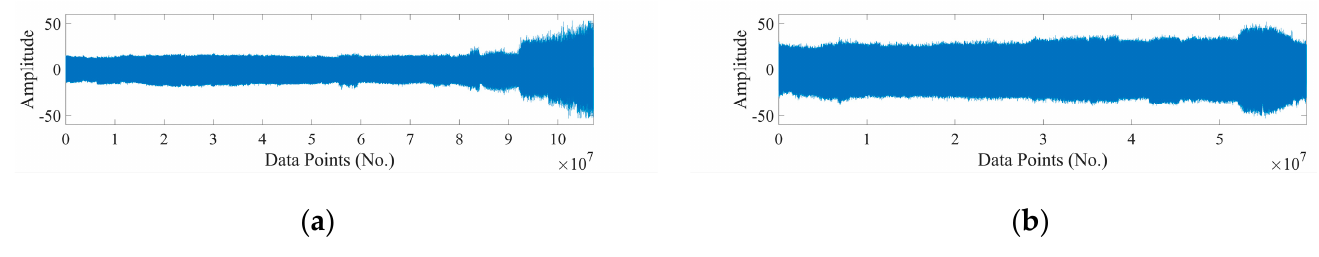
( b ) Figure 11. Experiment setup: ( a ) experiment equipment, ( b ) detailed schematic diagram of the test bench. The structural composition of the test bench is illustrated in Figure 11b. It mainly consisted of a motor, a torque sensor, a loading device and two gearboxes. An 11 kw three-phase induction motor acted as a drive. The torque needed could be adjusted by the torque sensor and loading device. A pair of gears with 17 and 19 teeth in gearbox 1 was the gears used for the test. Two pairs of bearings were deployed in each gearbox. To acquire the vibration signal, three accelerometers were placed on the gearboxes, where accelerometers 2 and 3 collected vertical sig- nals and accelerometer 1 collected both vertical and horizontal signals. In total, four channels of vibration signals were acquired with the sampling frequency at 20 kHz. Two-second-long vibration signals were collected every 10 min. As shown in Figure 12, two sets of vibration data were obtained to validate the developed method, which were named Dataset 1 and Dataset 2. A detailed